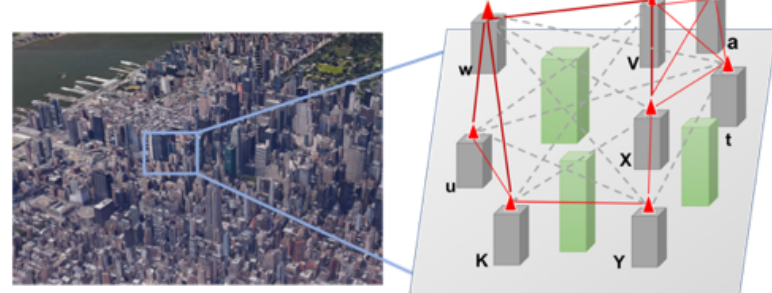
Figure 1. Visibility graph